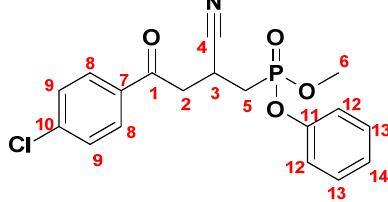
Figure 6. The structure of compound 5f .